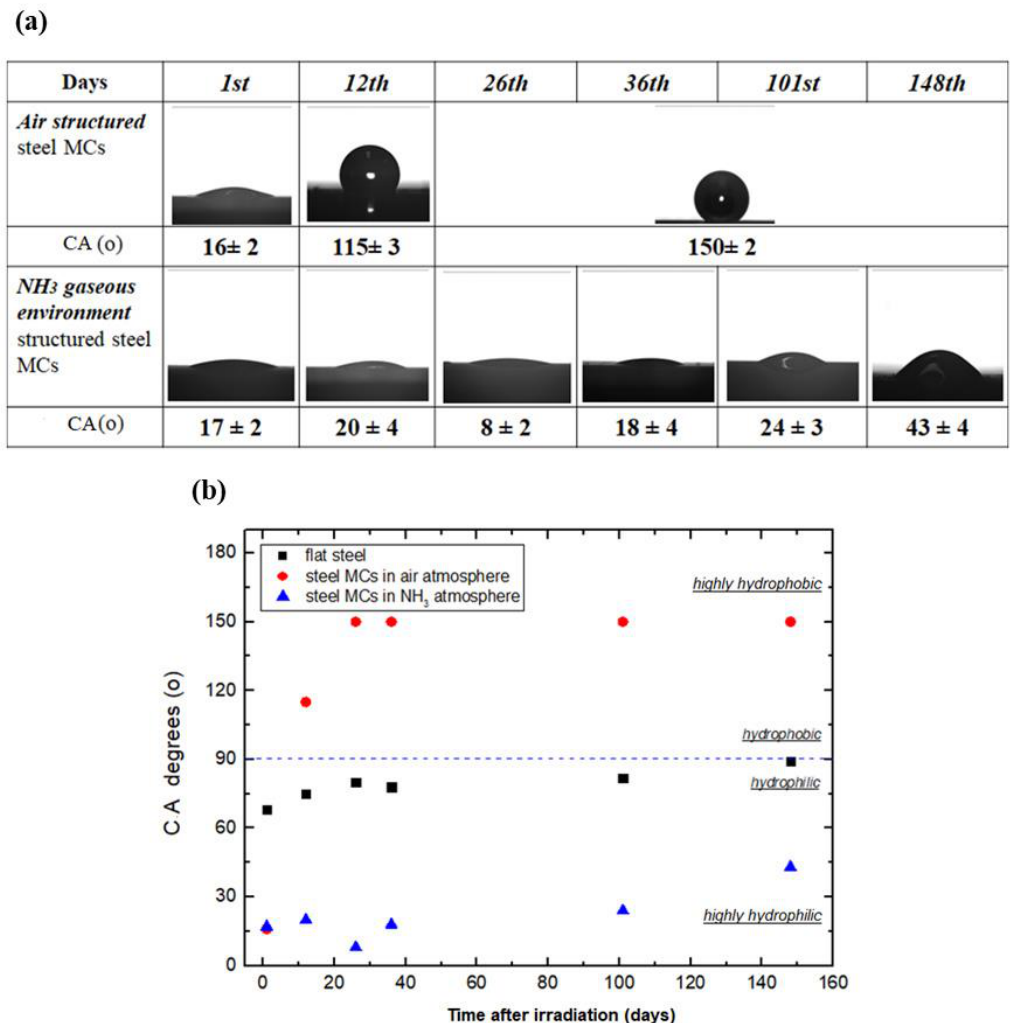
Figure 3. ( a ) Evolution of the profile of a water droplet placed onto laser-fabricated steel surfaces in air (top) and NH 3 (bottom) atmosphere, respectively, as a function of the time after irradiation; ( b ) Contact Angle (CA) evolution for 148 measurement days of flat (black spots), air-structured (red spots) and ammonia-structured (blue spots) steel surfaces.